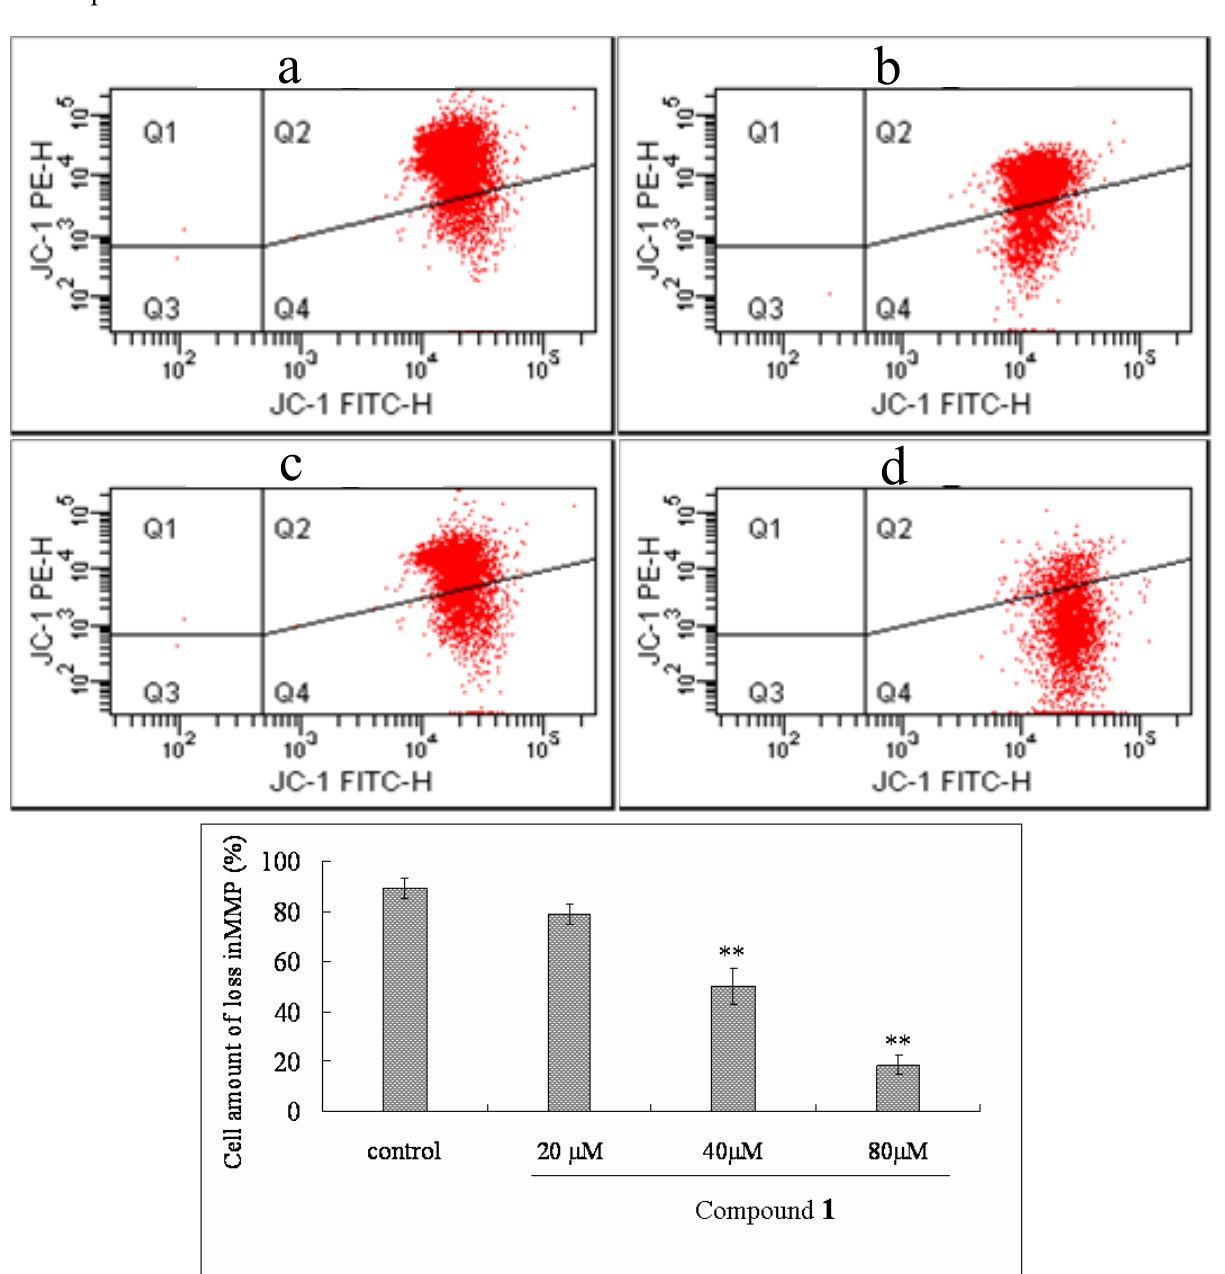
Figure 5, treatment with different concentrations of compound 1 (at 20, 40, 80 μ M) for 48 h induced a significant loss of MMP from 78.8% to 50.3% and 18.6% in a dose-dependent manner. Moreover, to assess the effect of compound 1 on intracellular ROS, after Bel-7402 cells were incubated with concentrations of compound 1 (at 20, 40, 80 μ M) for 48 h, intracellular ROS content was signi fi cantly increased from 130.45% to 237.3% and 362.7% (Figure 6) in a dose-dependent manner. Figure 5. Mitochondria membrane potential of Bel-7402 cells were determined by flow cytometric analysis following exposed to compound 1 for 48 h. Q2 district showed MMP normal cells and Q4 district demonstrated MMP loss cells. ( a ) Control, cells were not treated with compound 1 ; ( b-d ) cells were treated with compound 1 at concentrations of 20, 40 and 80 μ M, respectively. The data are represented as mean ± S.D for three independent experiments. * P < 0.05 and ** P < 0.01 vs.